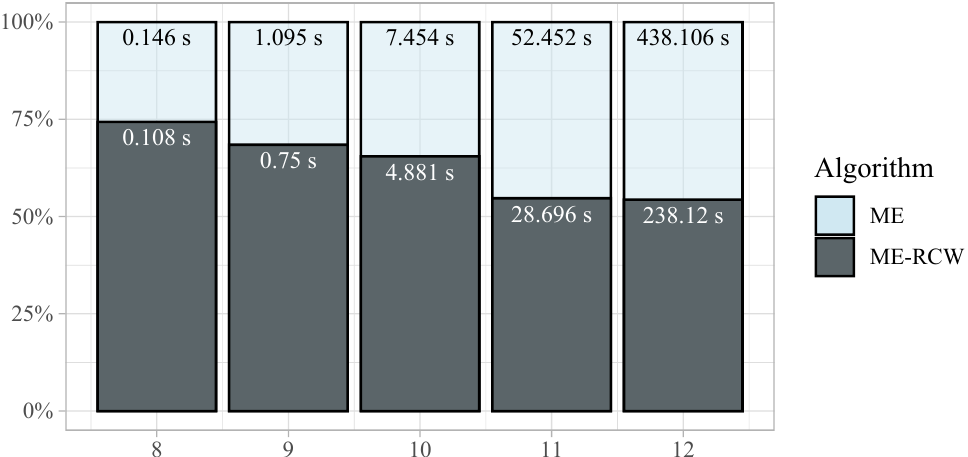
Figure 2. Execution time in seconds and percentage of time reduction of the three algorithms for the profiles of rankings for which the Condorcet winner exists. Results are presented for different numbers of alternatives.